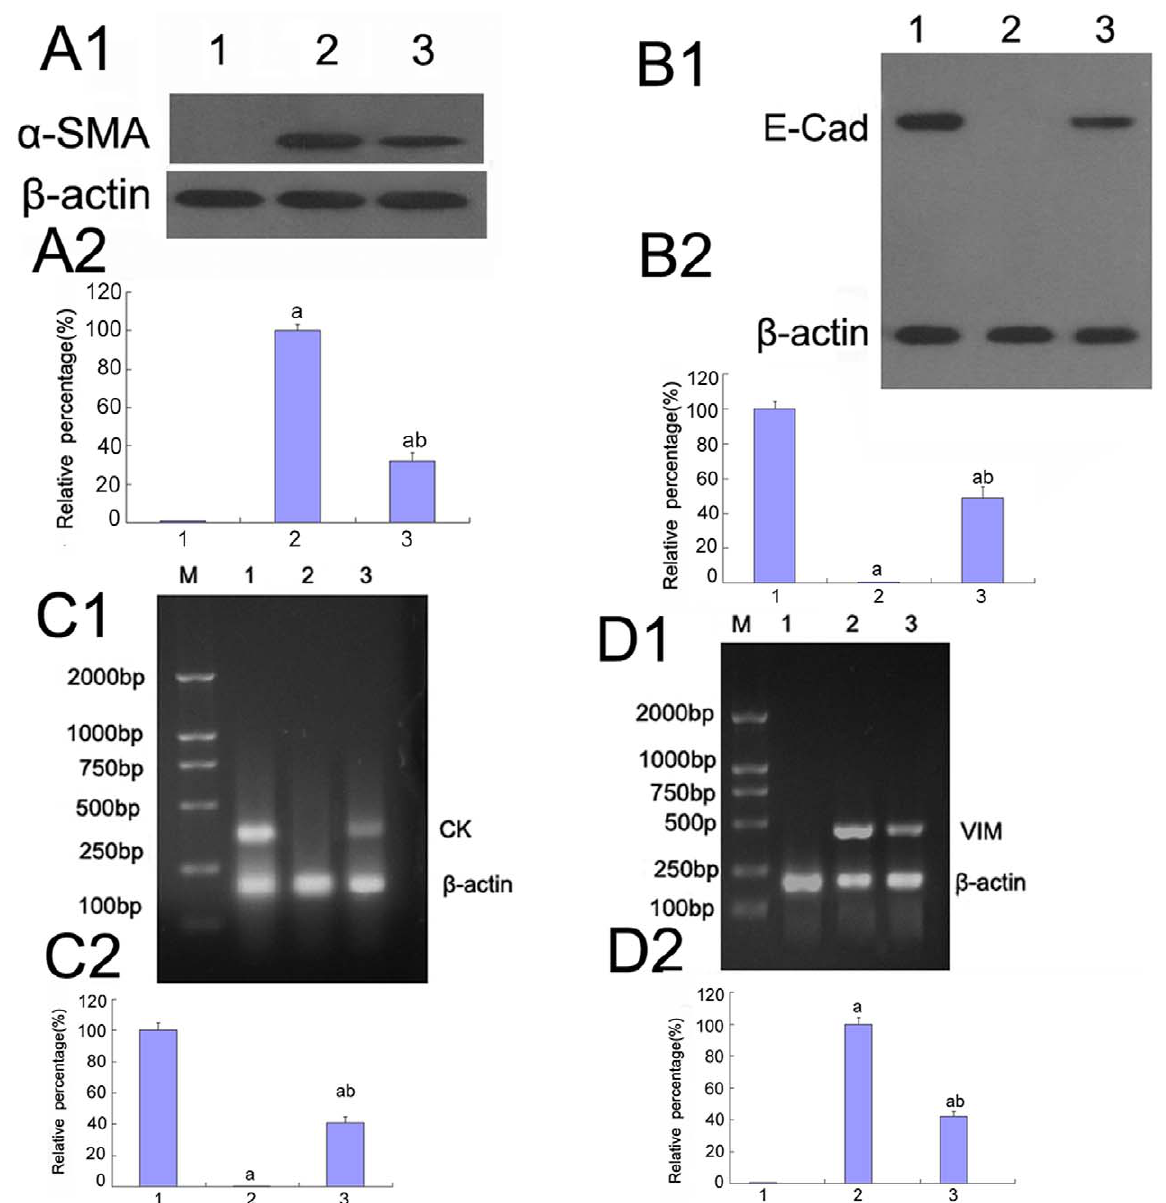
Figure 12. Expression of E-cadherin, CK, a -SMA, vimentin in HK-2 cells by Western blot and RT-PCR analysis. (A–B) a -SMA(A) and E- cadherin(B) were detected by Western blot of the HK-2 cells incubated in 5.5 mM glucose (lane 1), 30 mM glucose(lane 2), 30 mM glucose + AP-1 inhibitor(lane 3).(C–D)mRNA of CK(C) and vimentin(D) was measured by RT-PCR of the HK-2 cells incubated in 5.5 mM glucose (lane 1), 30 mM glucose(lane 2), 30 mM glucose + AP-1 inhibitor(lane 3). Values represent the mean 6 SD. a P , 0.05 vs. 5.5 mM glucose, b P , 0.05 vs. 30 mM